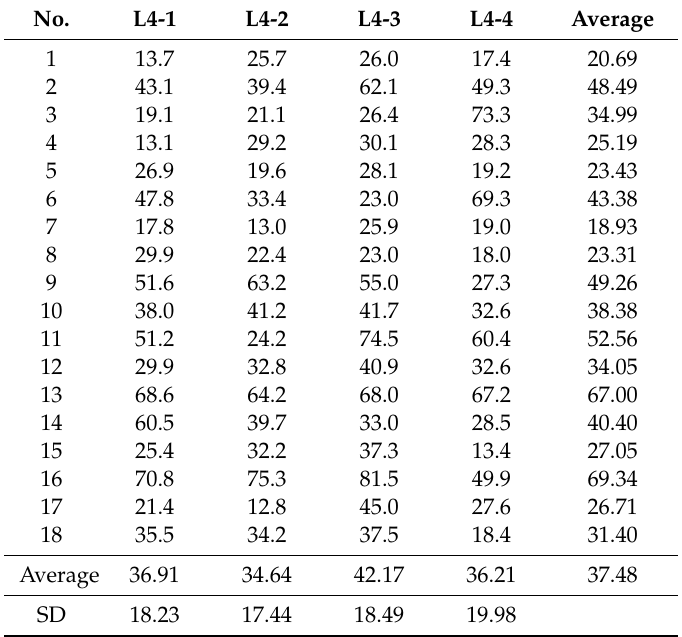
Table 5. Yield (%), average, and SD of each synthesized smectite in the experimental combinations.